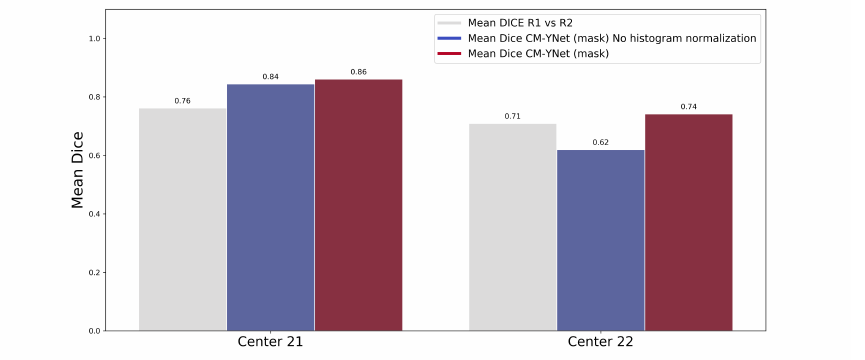
Figure 7. Comparison of CM-YNet (mask) segmentation with and without the preprocessing step on the IMIM dataset. The results using the proposed histogram normalization outperformed those obtained without any preprocess, especially for the low-quality images of Center 22 ( p <